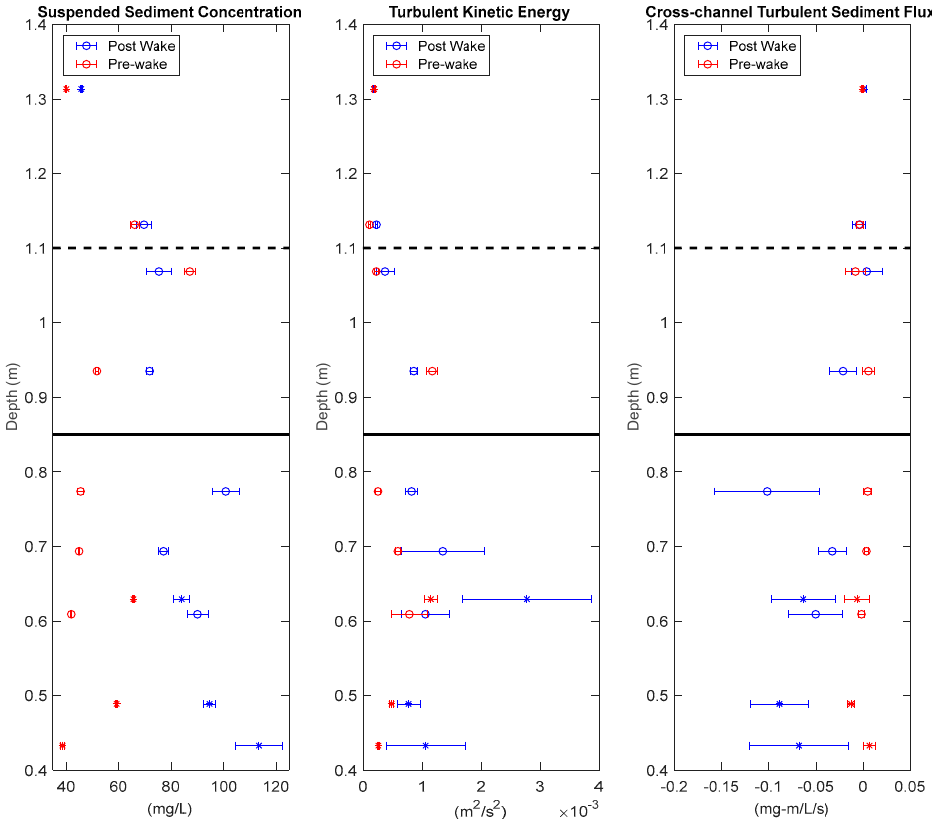
Figure 6. Concentration and turbulence quantities pre- and post-vessel wake as a function of water depth. ( A ) Sediment concentration, ( B ) turbulence kinetic energy, and ( C ) cross-shore sediment flux. Open circles denote measurements at Station 1 and stars denote measurements at Station 2. The solid (dashed) horizontal line denotes the toe of the scarp (marsh platform) at Station 1. The marsh platform height and scarp are not depicted at Station 2 as all measurements with a detectable wake signal were below the scarp. Error bars denote 95% confidence limits.